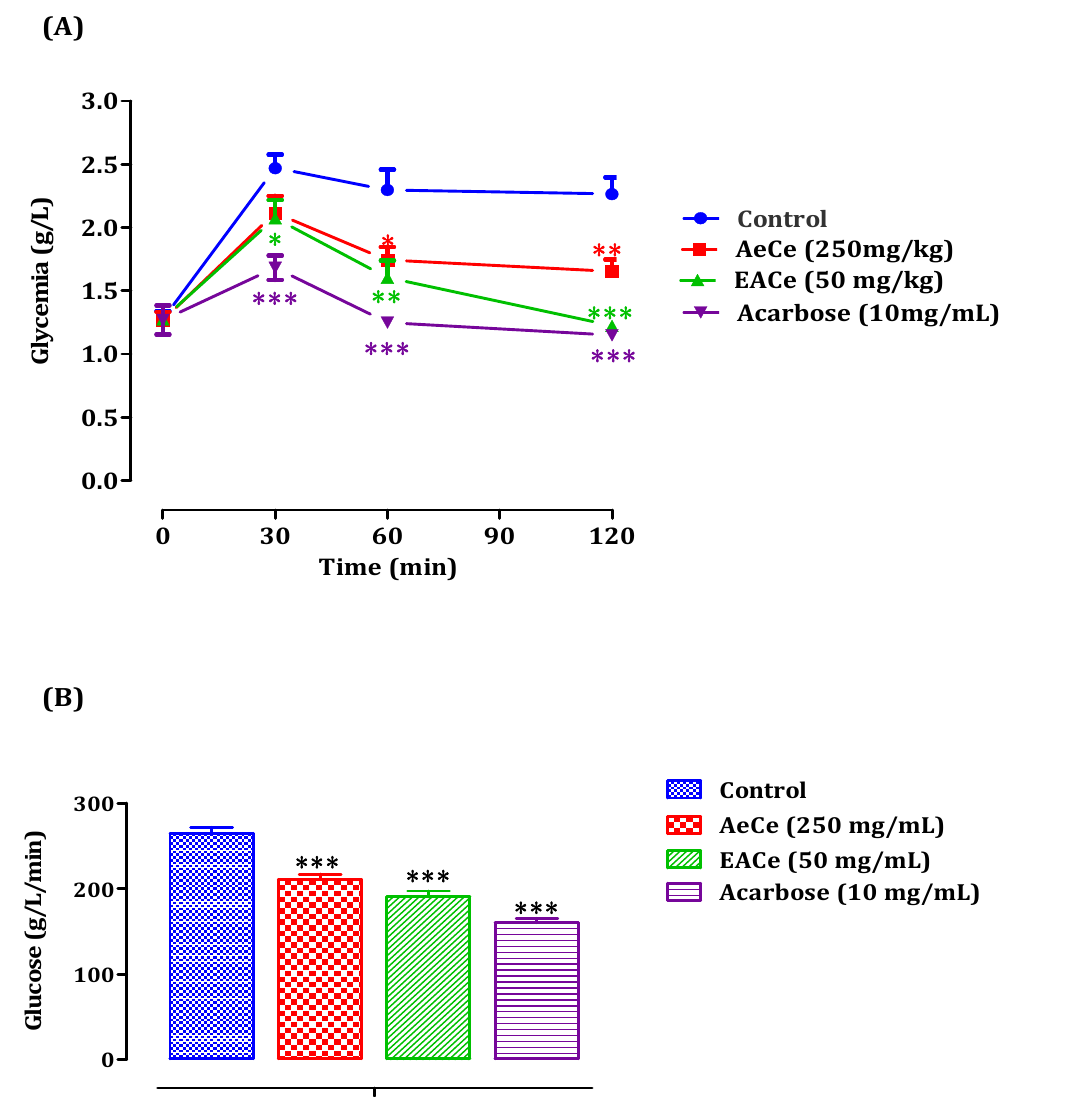
Figure 7. Effect of AeCe, EACe, and acarbose on plasma glucose levels after starch intake in diabetic rats ( A ), with a representation of the area under the curves ( B ). The values are the means ± SEM ( n = 6). * p < 0.05, ** p < 0.01, and *** p < 0.001 compared to the control group.